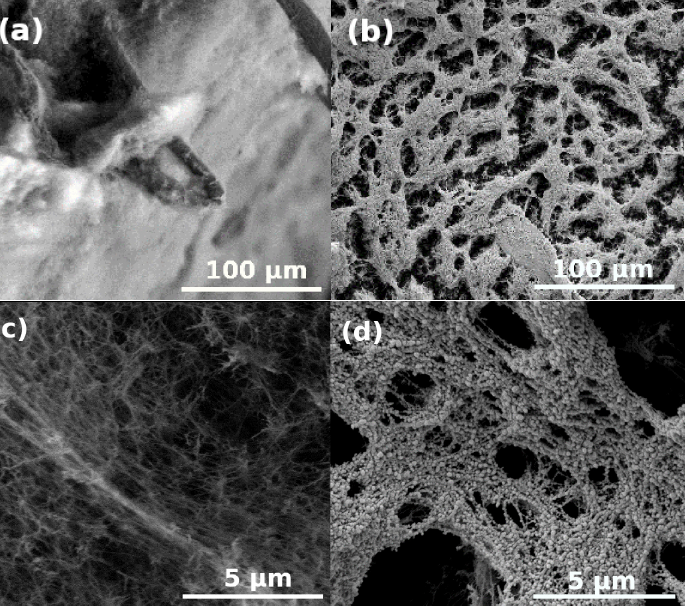
Figure 8. LVSEM images of cellulose aerogel samples. ( a , c ) Pristine, uncoated. ( b , d ) Plasma coated for 2.5 min.